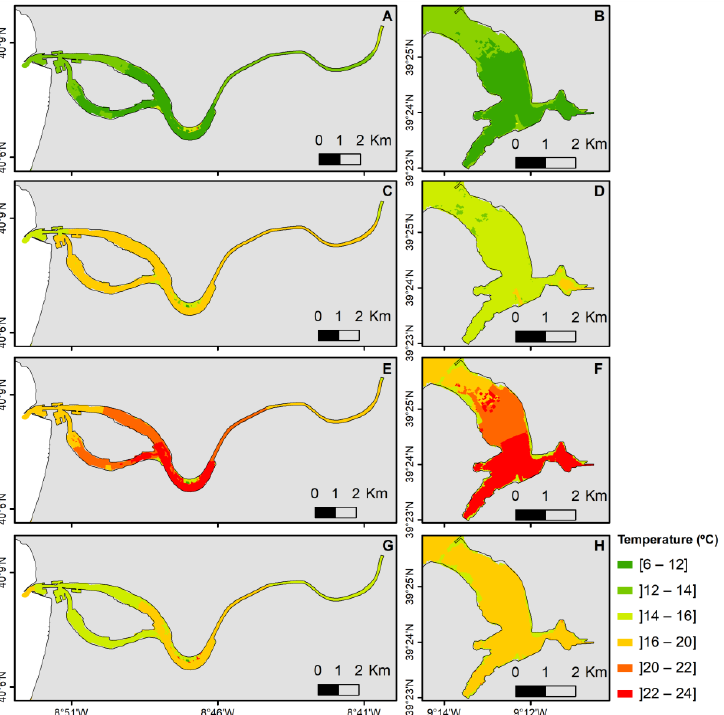
Figure 9. Seasonal mean of water temperature (°C) for Mondego Estuary (left) and Ó bidos Lagoon (right): ( A , B )—winter; ( C , D )—spring; ( E , F )—summer; ( G , H )—autumn. J. Mar. Sci. Eng. 2021 , 9 , x FOR PEER REVIEW